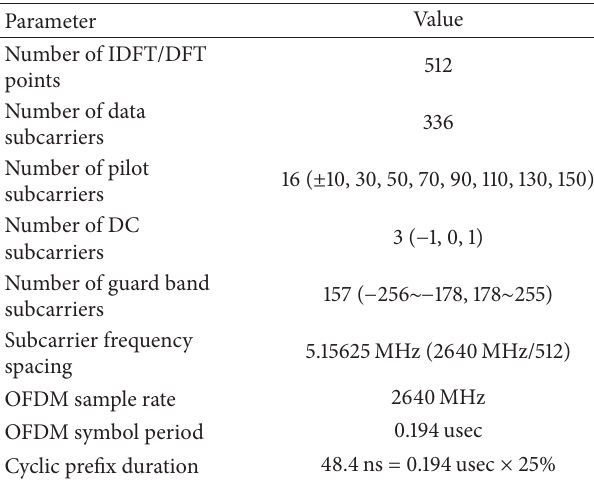
Table 1: WiGig/IEEE 802.11ad OFDM